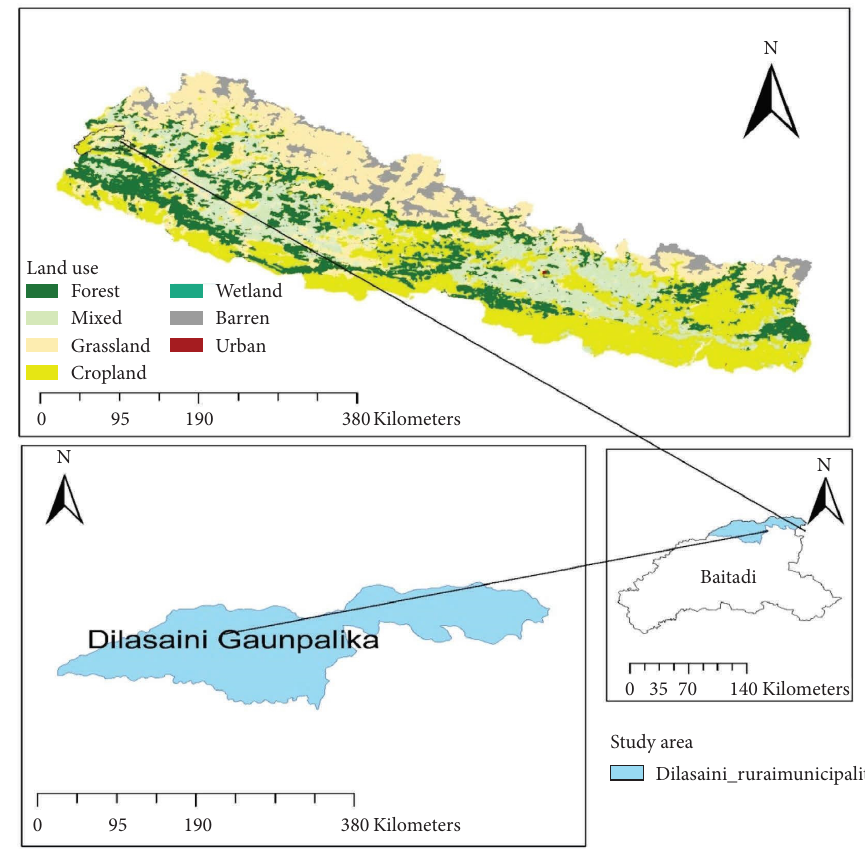
Figure 1: Map of the experimental area in Nepal.